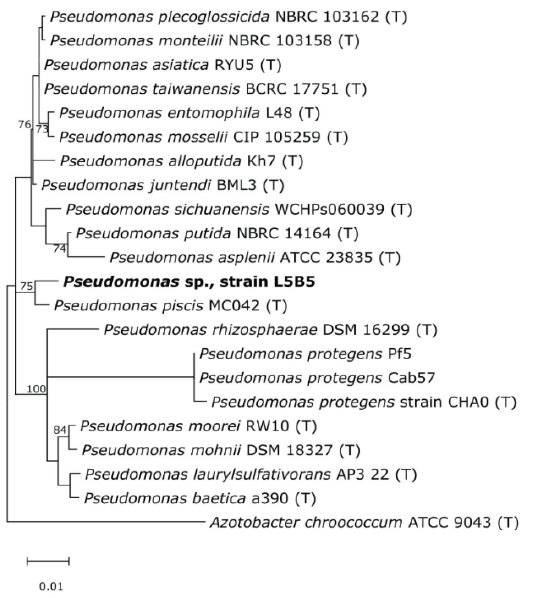
Figure 4. Maximum-likelihood phylogenetic tree based on rRNA 16S gene sequences, showing relationship of Pseudomonas sp., strain L5B5, with the closest species of the genus Pseudomonas . Bootstrap values (>50%) are represented. Azotobacter chroococcum ATCC 9043 was used as